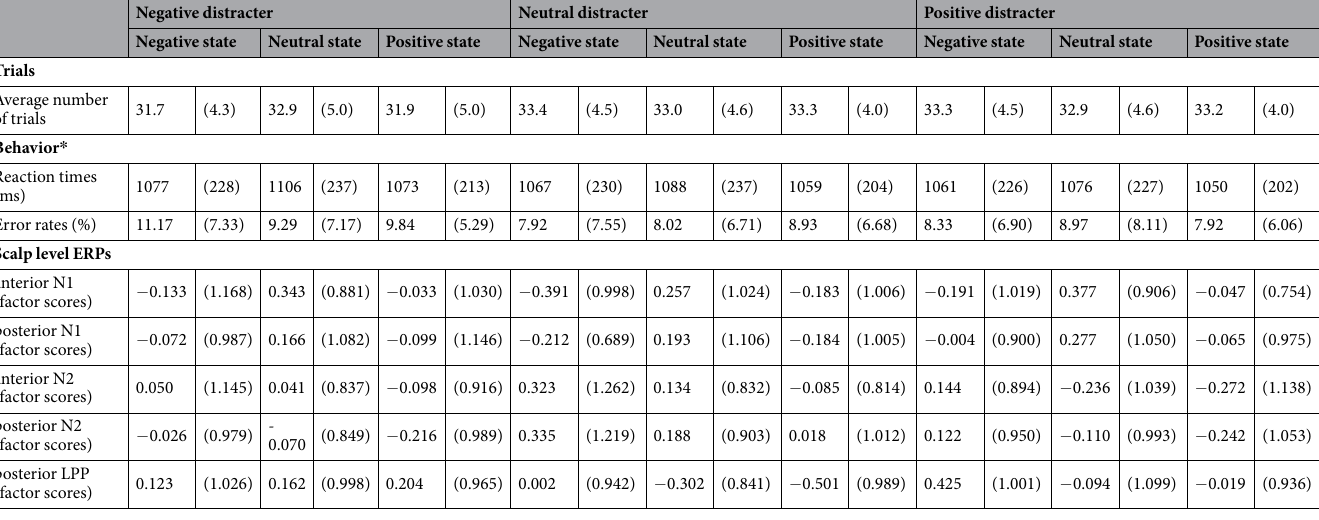
Table 1. Means and standard deviations (in parenthesis) of: (i) average number of trials, (ii) behavioral responses, and (iii) neural responses (factor scores, linearly related to amplitudes). * To achieve normality, analyses were performed on transformed data: log10[RT]), arcsin[ √ ER].